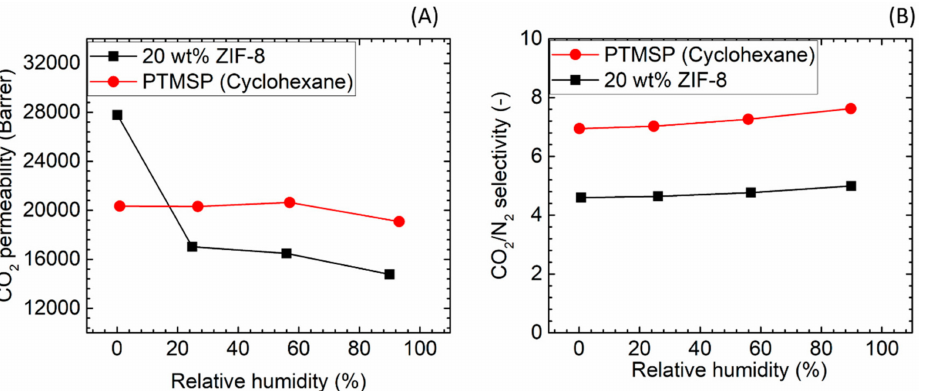
Figure 9. Gas separation performance of PTMSP/ZIF-8 hybrid membranes. ( A ) CO 2 permeability and ( B ) CO 2 /N 2